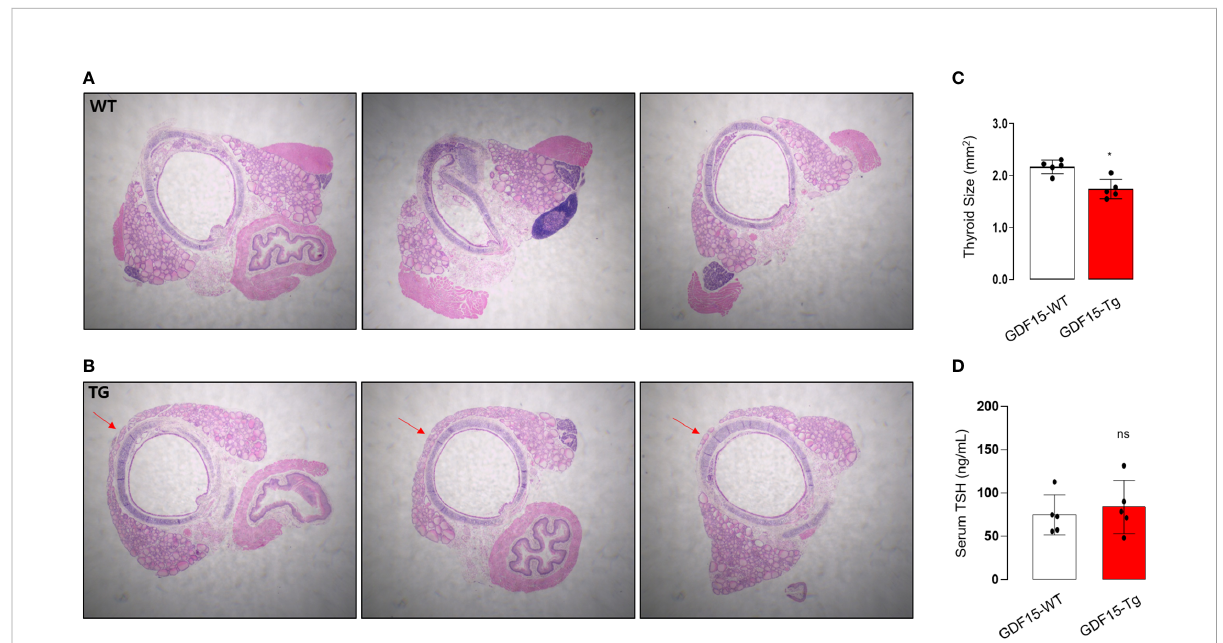
FIGURE 3 Morphological phenotype of liver-speci fi c GDF15 transgenic (Tg) mice. (A, B) Representative hematoxylin and eosin staining images (40× magni fi cation) of the thyroid glands from wild type (WT) (A) and GDF15-Tg mice (B) . Red arrows indicate the isthmus. (C) Comparison of thyroid gland size between the two groups (n = 5). To minimize the selection bias that the size varies depending on the location of the transverse histologic section, the largest area was measured using Image-J. (D) Comparison of thyroid stimulating hormone (TSH) levels between the two groups (n = 5). * Statistically signi fi cant differences in nonparametric Mann-Whitney U-test (p-value <0.05). ns, no signi fi